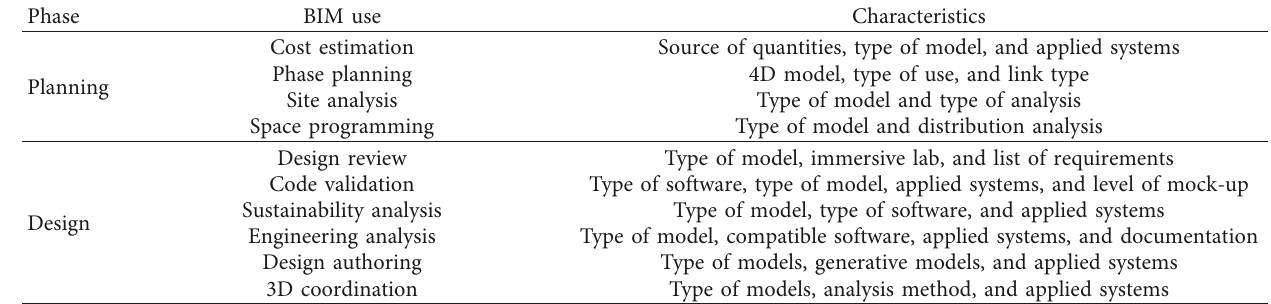
Table 5: Uses and their